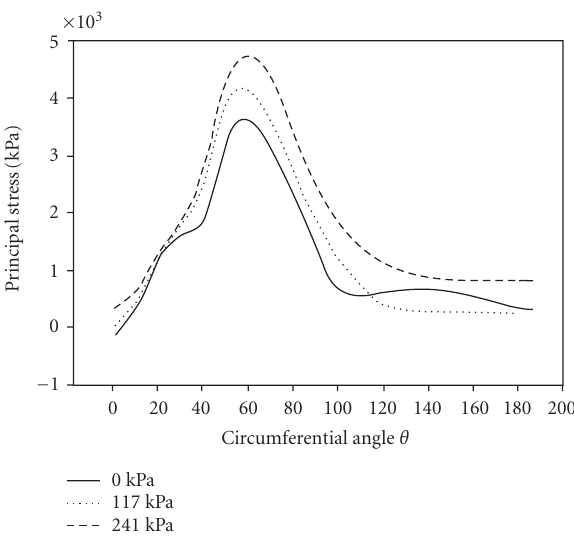
Figure 15: Variation of the maximum principal stress on the rim as a function of circumferential angle for an inflation pressure of 0